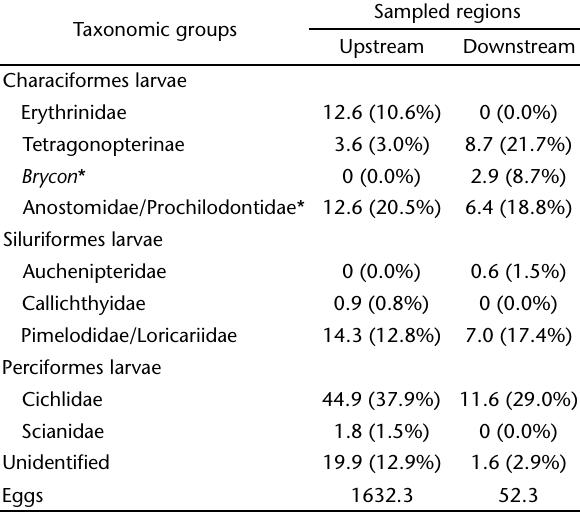
Table I. Density (n/m 3 ) and relative abundance (%) of larvae of each taxonomic group and eggs density (n/m 3 ) upstream of the reservoir and downstream of the Santa Clara dam.